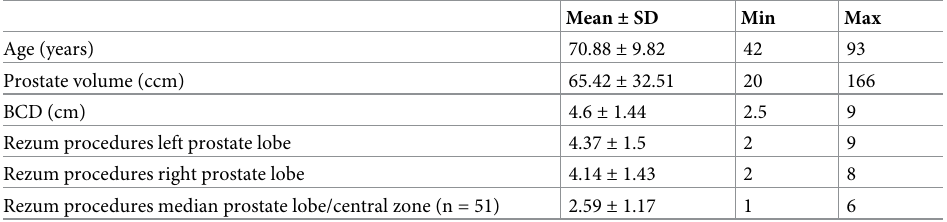
Table 1. Patients’ characteristics at baseline and interventional data. Values are mean ± standard deviation (SD). BCD = bladder neck-colliculus-distance (cm). Min = minimum. Max =